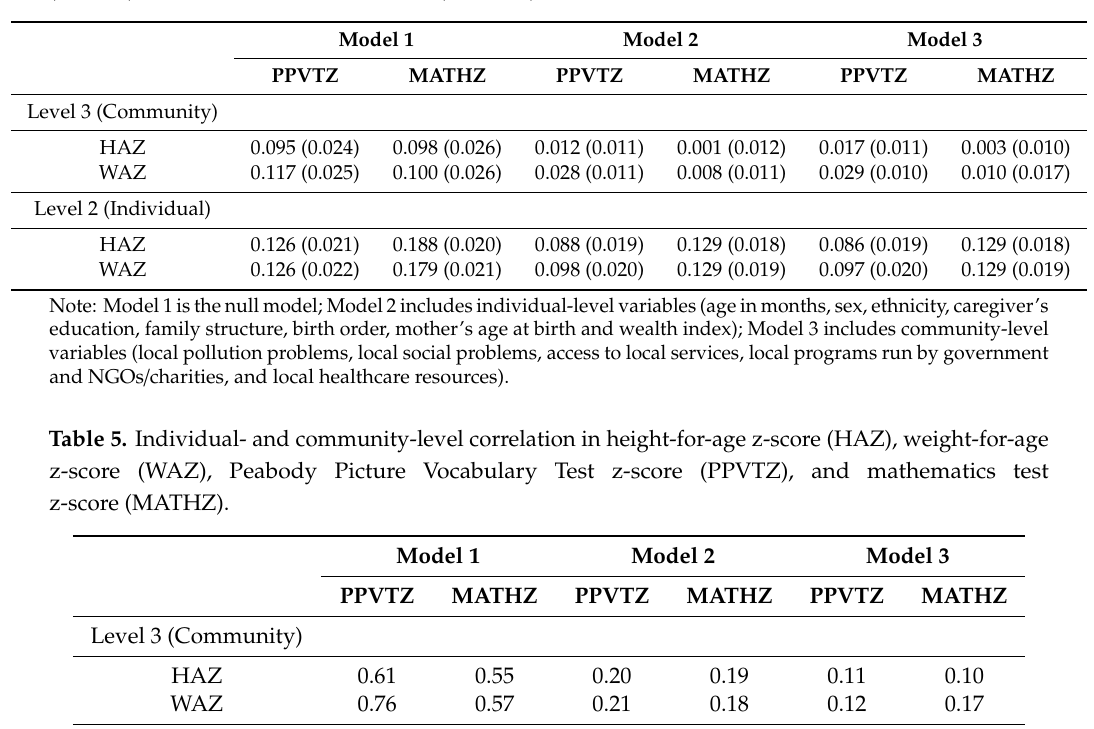
Table 4. Individual- and community-level covariance and standard errors (in parentheses) in height-for-age z-score (HAZ), weight-for-age z-score (WAZ), Peabody Picture Vocabulary Test z-score (PPVTZ), and mathematics test z-score (MATHZ).